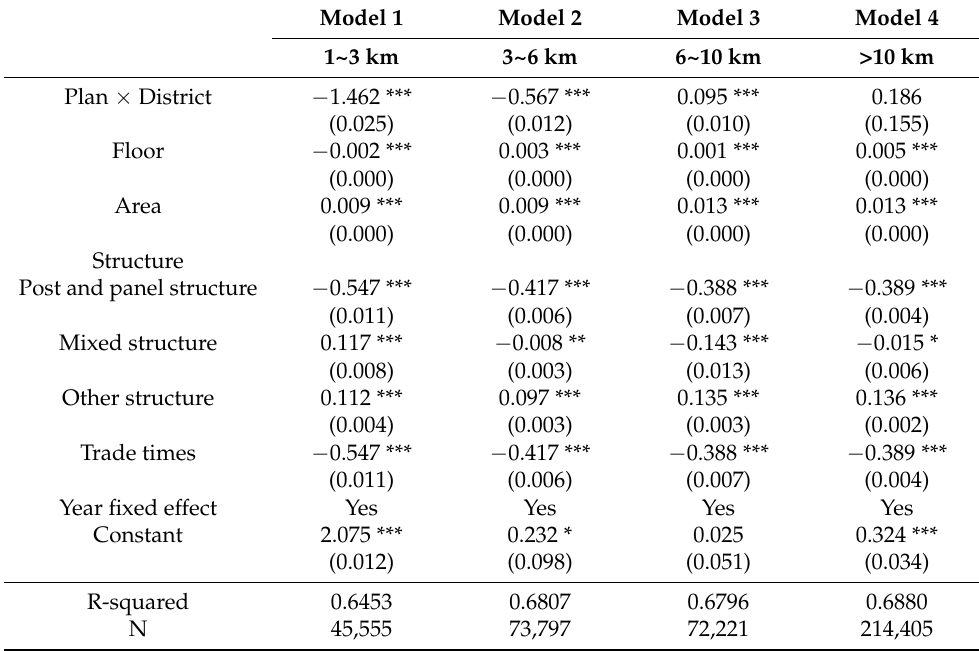
Table 5. Regional heterogeneity of the impact of the construction of the National Big Data (Guizhou) Experimental Area on residential transaction